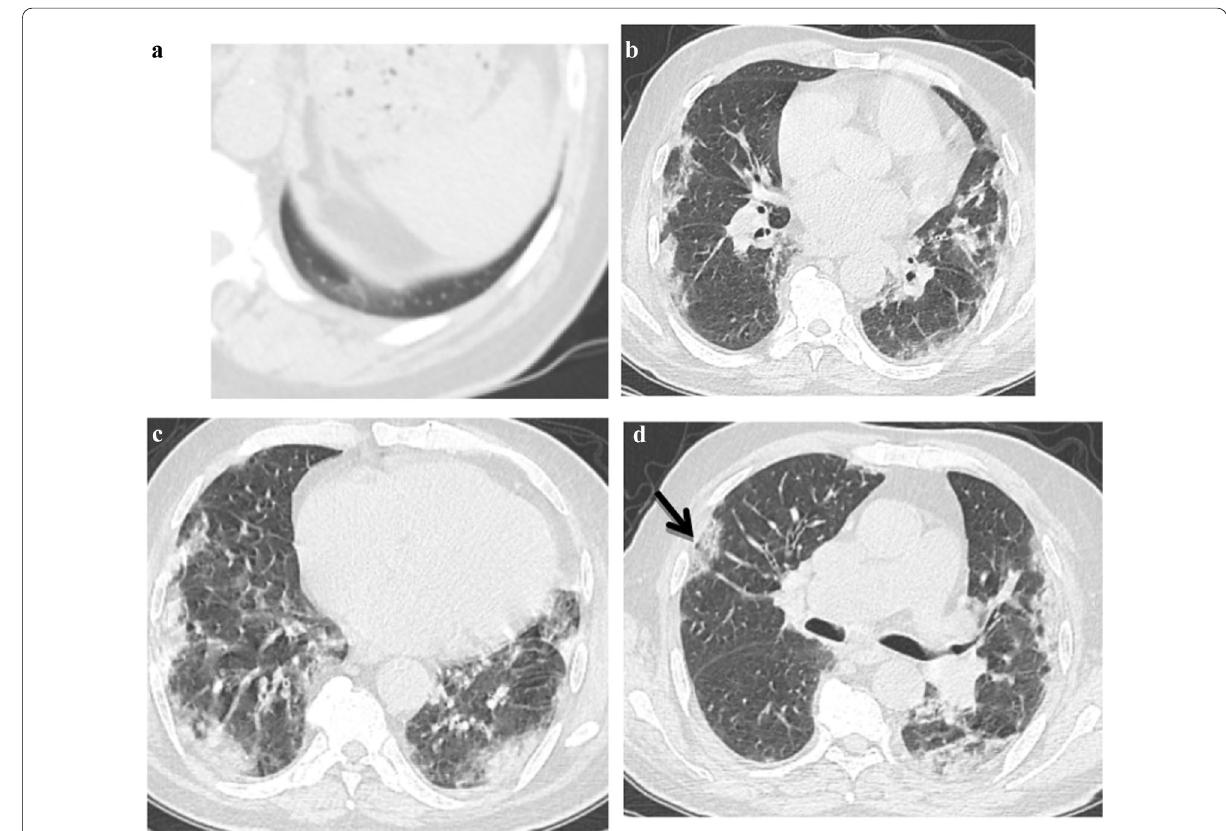
Fig. 3. A 71-year-old male known cardiac presented with anosmia, fever and myalgia at March 2020 and positive PCR for COVID 19 infection, a noncontrast CT axial cuts shows bilateral few small subpleural faint ground glass opacities. The patient diagnosed as COVID 19 infection with CT score severity: 4. Second infection dated January 2021 the patient presented with fever, respiratory distress, cough and myalgia with positive PCR test for COVID 19 infection. b – d noncontrast CT chest images show bilateral patchy ground glass opacities with crazy paving sign (Arrowed) and consolidations. The patient diagnosed as COVID 19 re-infection with CT severity score: